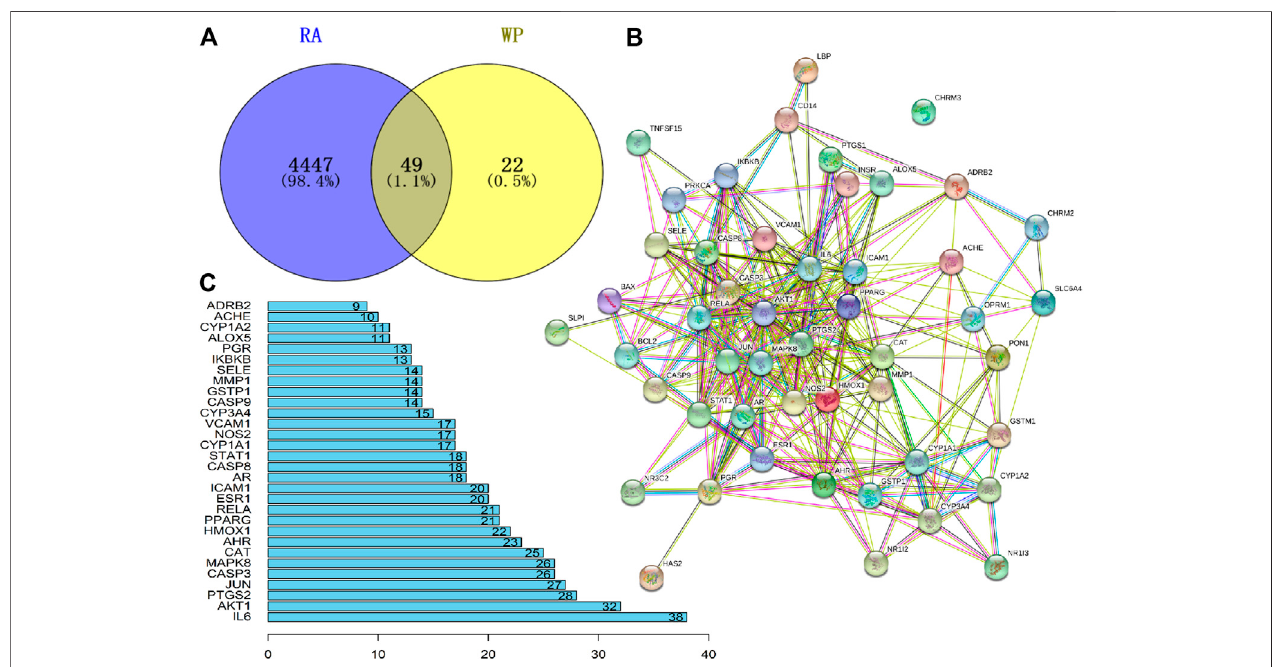
FIGURE 2 | Potential target genes and PPI network map of WP therapy for RA. (A) The Venny results of potential target genes of WP therapy for RA. (B) The PPI network map of 49 target genes. (C) Count and list of the top 30 genes of PPI network map.